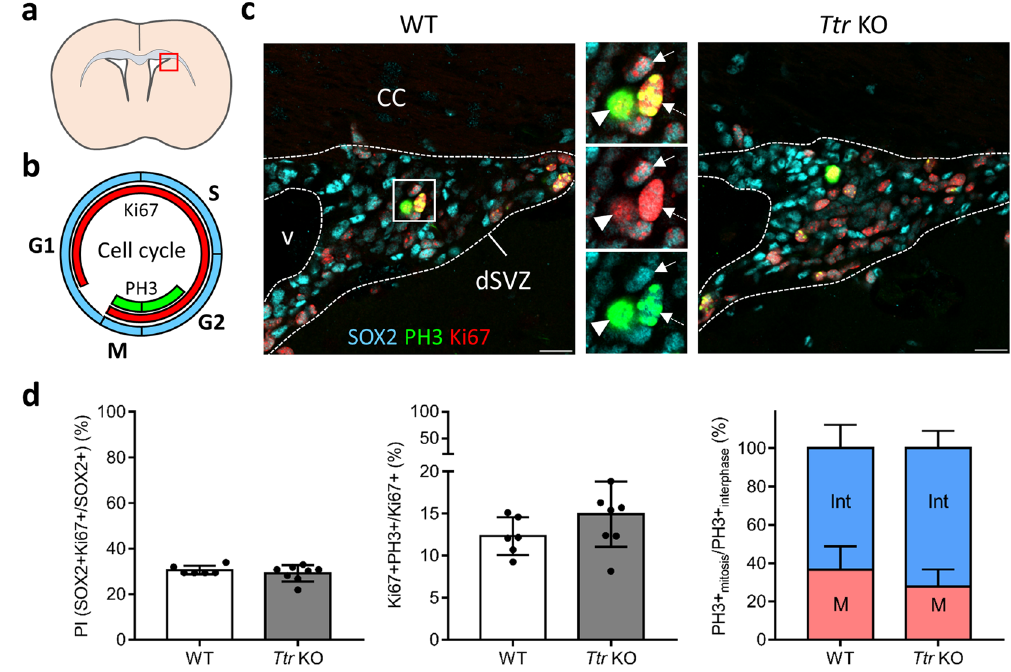
Figure 3. Ttr KO does not affect progenitor cell proliferation and cell cycle progression. ( a ) Schematic representation of the SVZ region highlighted in C (the dorsal SVZ, red box). ( b ) Scheme of the cell cycle, divided in four phases: S, G2, M, and G1. Ki67 (red) is expressed throughout the almost entire cell cycle, while PH3 (green) marks the late interphase (G2) and mitosis (M). ( c ) Representative pictures of a WT and Ttr KO dorsal SVZ showing SOX2 + progenitors (light blue), Ki67 (red), and PH3 (green). The inserts show some SOX2 + cells expressing Ki67 (arrow). PH3 + cells have a dotted staining pattern in late G2-phase (dotted arrow), and a pan- nuclear staining pattern during the M-phase (arrowhead). No obvious changes were noticeable in Ttr KO mice. Scale bars: 20 µ m ( d ) The proliferation index (left graph), the proportion of Ki67 + cells co-stained with PH3 (middle graph), as well as the ratio of PH3 + cells in G2- and M-phases (right graph) are similar between WT and Ttr KO mice (n = 6–8, two-tailed Student’s T tests or Mann-Whitney U test). Bars represent mean ± SD. CC: corpus callosum; dSVZ: dorsal subventricular zone; Int: interphase; M: mitosis; PI: proliferation index; v: